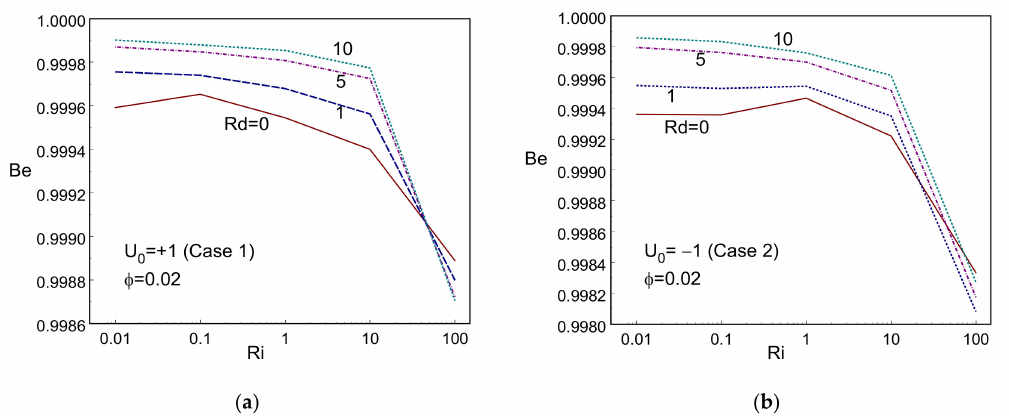
Figure 15. Bejan number for di ff erent Ri and Rd values. ( a ) Case 1; ( b ) Case